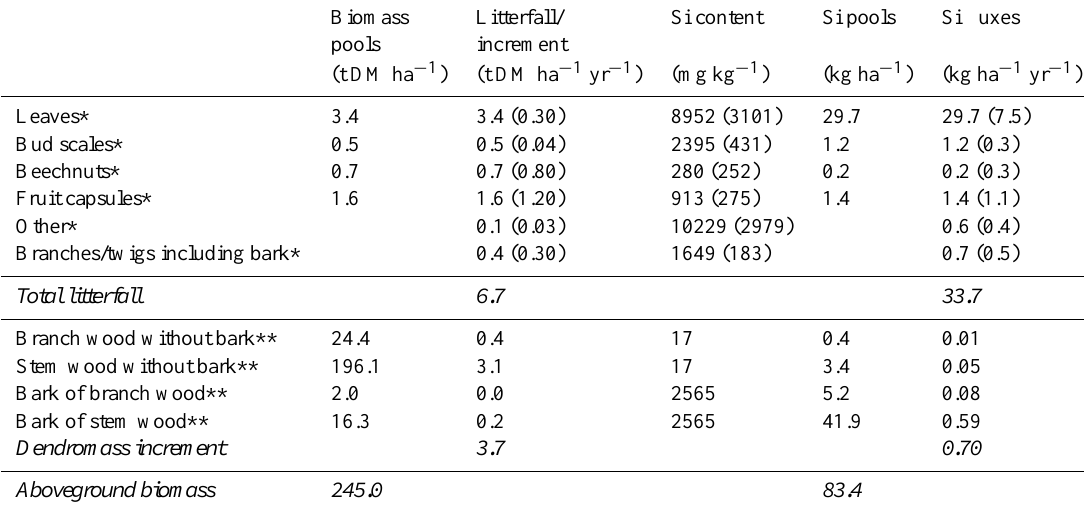
Table 4. Pools and increments of plant biomass, Si concentrations (mass weighted mean values), Si pools in aboveground biomass, Si fluxes with increment of tree biomass; *: calculated from litter fall of 05/2006–04/2010; **: calculated from stem volume of 2010 or stem growth of 2006–2009; no. in brackets=std.dev. ( n = 4yr). Biomass Litterfall/ Si content Si pools Si fluxes pools increment